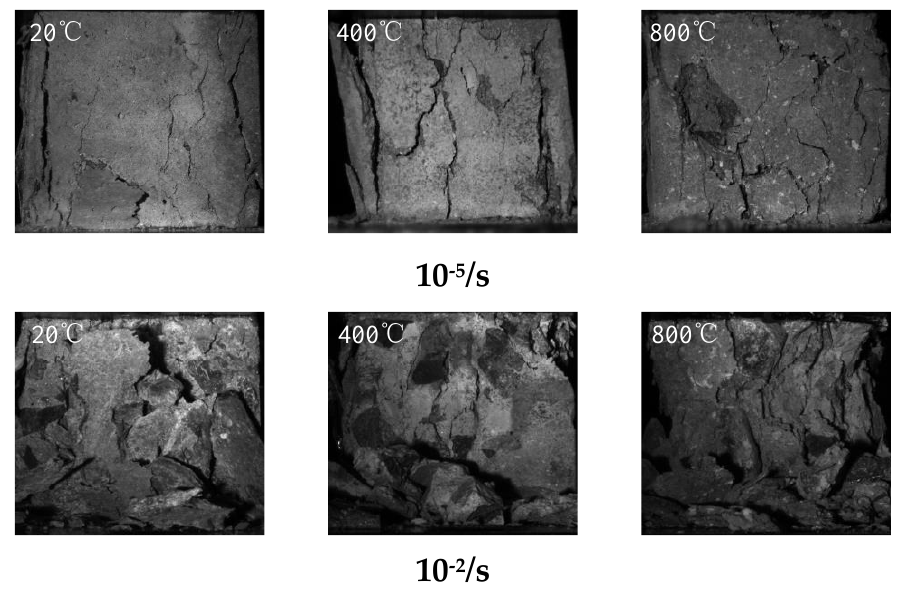
Figure 8. Final damage morphology of concrete under different temperatures and strain rates.